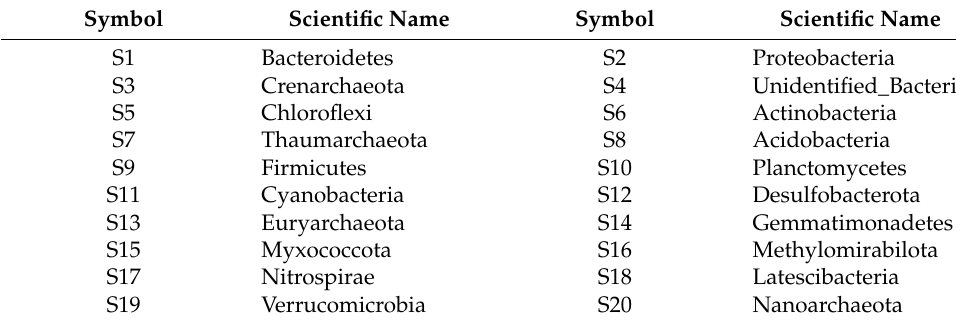
Table 3. Symbols for microbial phyla used in canonical correspondence analysis.